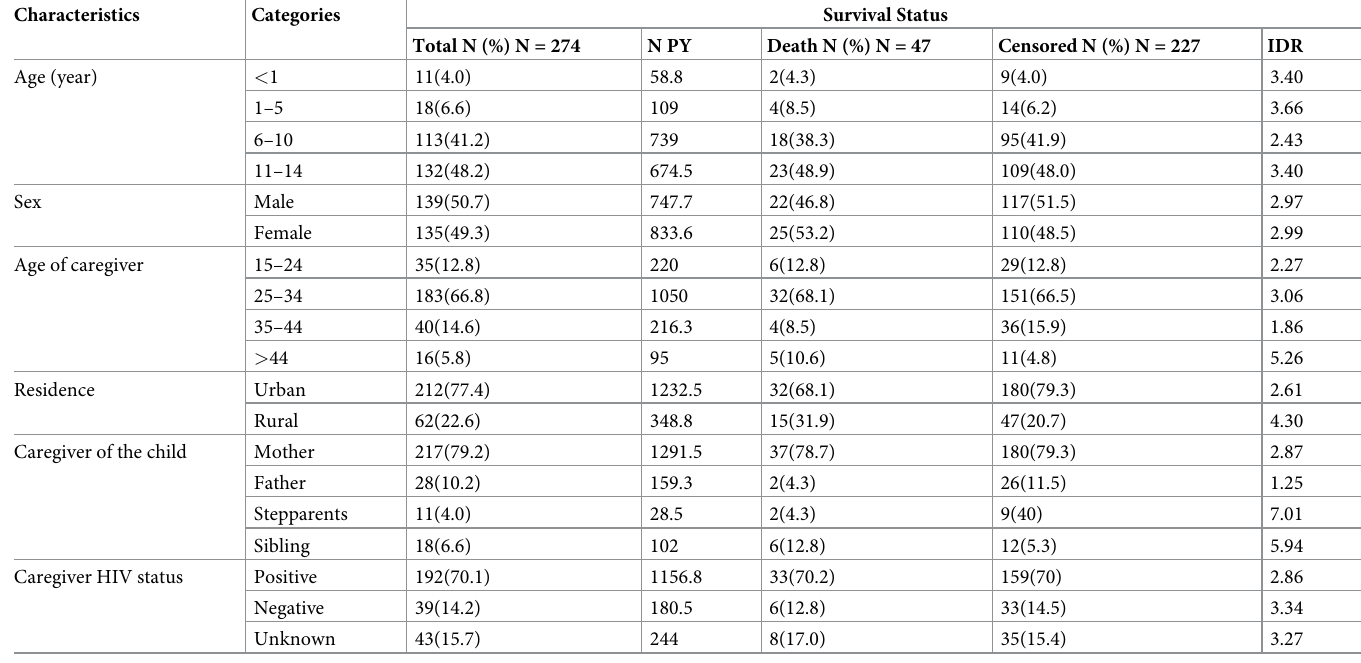
Table 1. Socio-demographic characteristics of TB/HIV co-infected children at public hospitals in Southern Ethiopia, 2020.